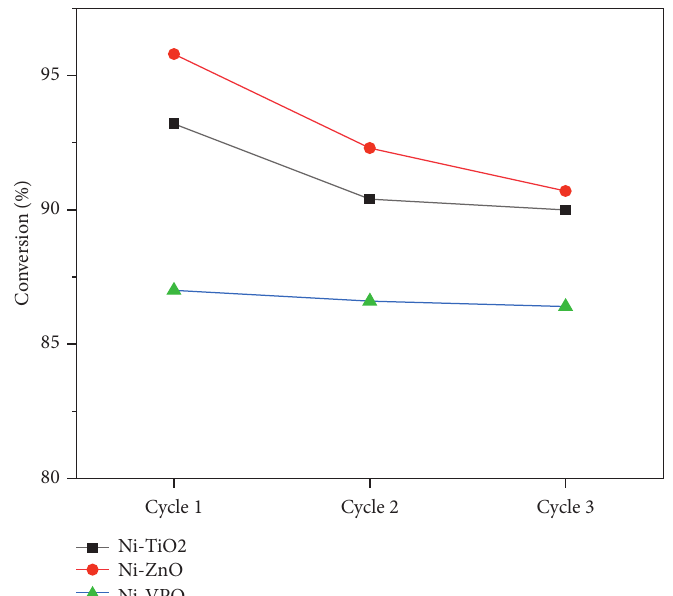
Figure 8: The conversion of 3-chlorophenol in hydrodechlorination with recovered Ni-X catalysts. Reaction condition: catalysts (2mol%); methanol as a solvent in the presence of 5% aqueous solution of KOH at RT within Figure 5. No significant difference could be distinguished in